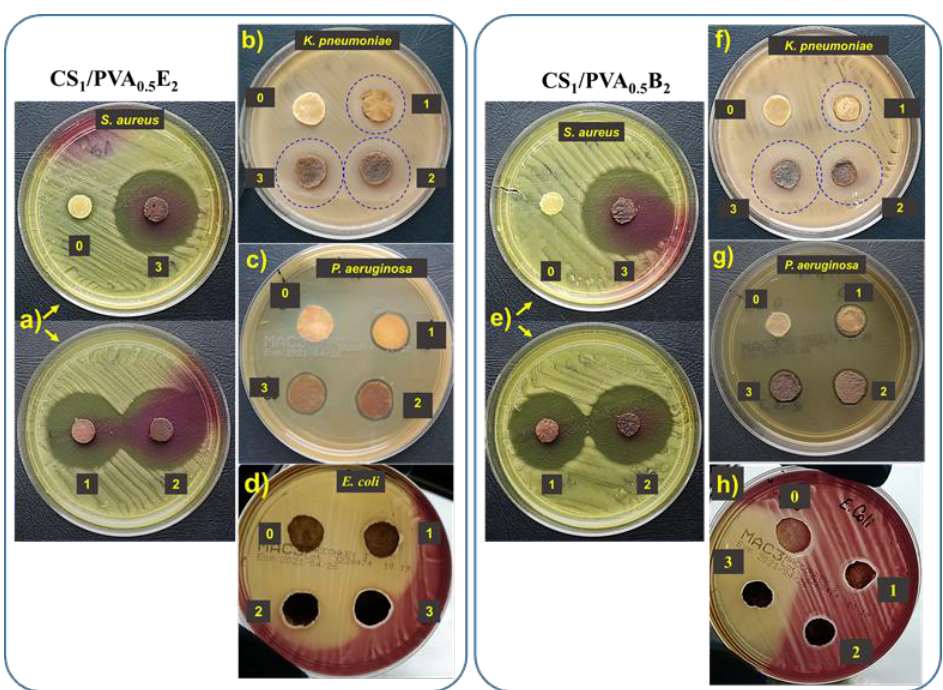
Figure 7. Antibacterial activity of CS 1 /PVA 0.5 E 2 and CS 1 /PVA 0.5 B 2 hydrogels against S. aureus ( a , e ), K. pneumonia ( b , f ), P. aeruginosa ( c , g ), and E. coli ( d , h ): zone 0, the hydrogel without AgNPs; zone 1, hydrogel with AgNPs obtained in 1 mM AgNO 3 solution; zone 2, hydrogel with AgNPs obtained in 5 mM AgNO 3 solution; zone 3, hydrogel with AgNPs obtained in 10 mM AgNO 3 solution.